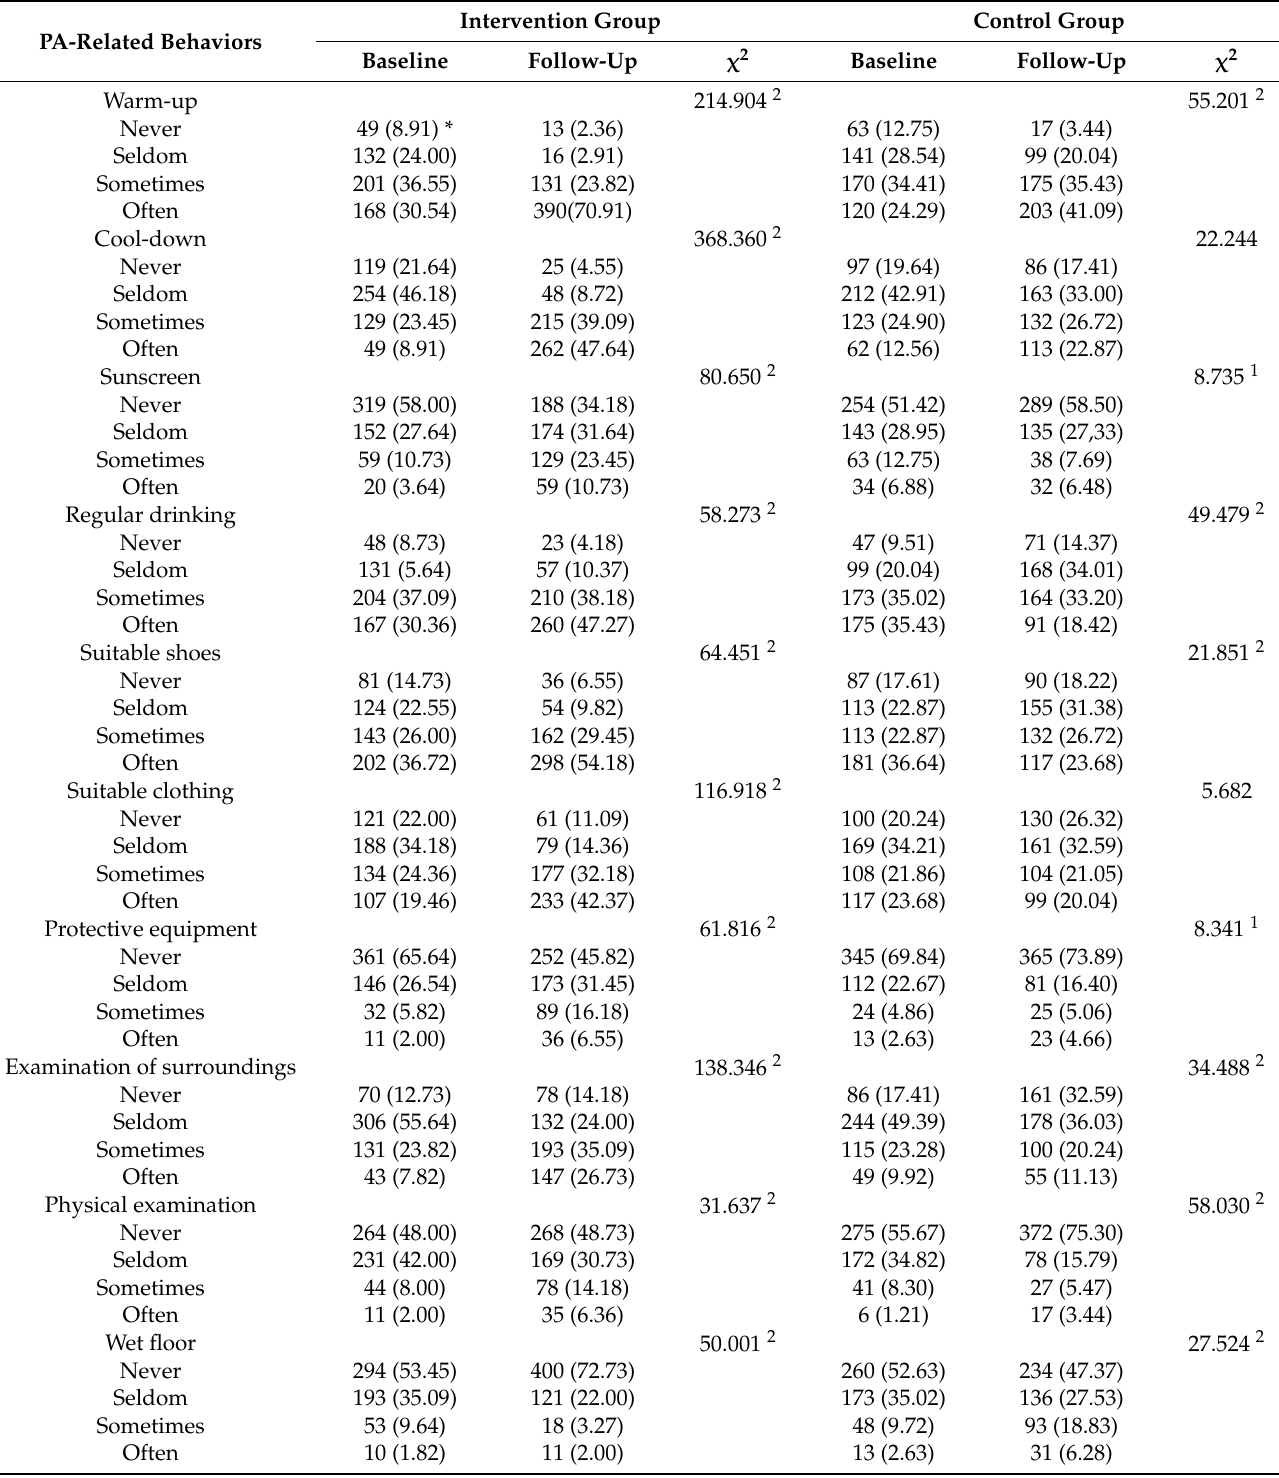
Table 4. Comparison of PA-related behaviors before and after intervention in both intervention and control